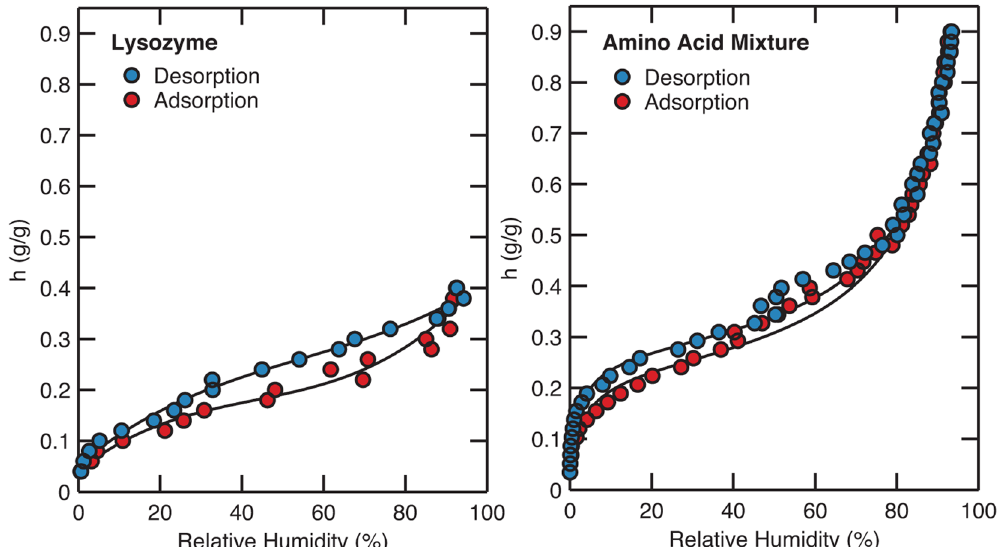
Figure 3. Water sorption isotherms of lysozyme (left, reprinted with permission from Kim et al . J . Phys . Chem . Lett ., 8, 1185–1190 (2017) 21 . Copyright 2017 American Chemical Society.) and the amino acid mixture of the same composition as lysozyme (right). Black lines are drawn as a guide to the